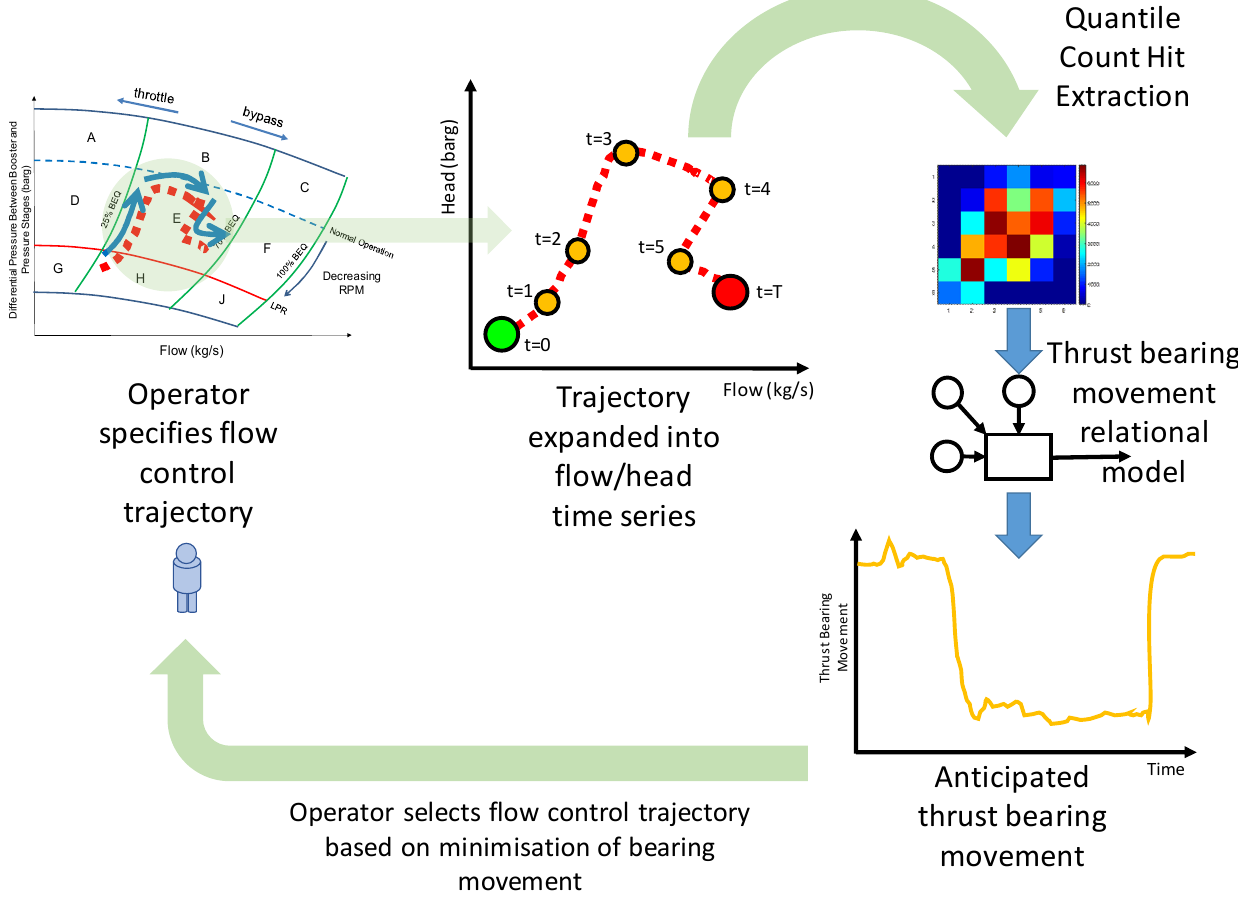
Figure 10. Work flow for planning pump operation and managing operating parameters in transitions between operating states.